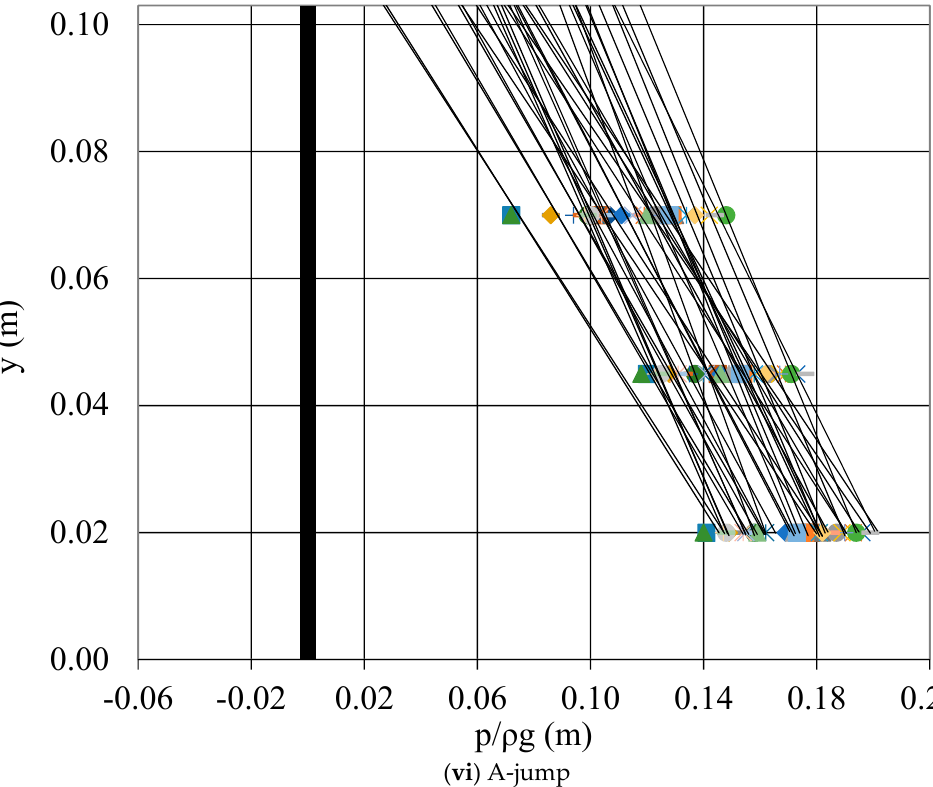
Figure 8. Distribution of the measured pressure head at the face of step with three piezometers, extended linearly to the top ( i ) supercritical flow, ( ii ) min B-jump, ( iii ) B-jump, ( iv ) wave-train, ( v ) wave-jump, and ( vi ) A-jump.